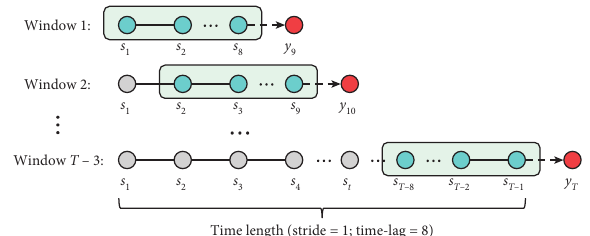
Figure 7: Illustration of rolling